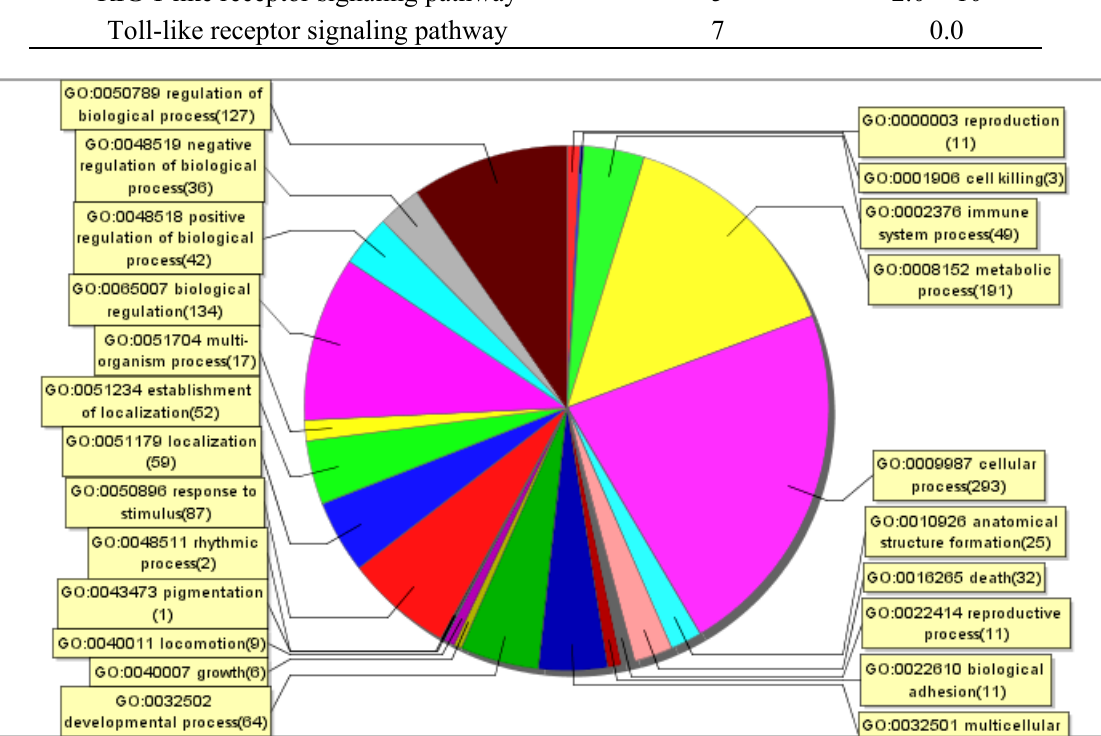
Figure 1. Enriched Gene Ontology terms in the biological process category among differentially expressed genes. After the mRNA microarray assay, significantly enriched Gene Ontology analysis in the biological process category among differentially expressed genes (fold change over non-infected ≥2) in Raw264.7 cells infected with SX09S-01 at 5 MOI for 2 h was performed by using SAS (ShanghaiBio Analysis System). Each color section represents a different biological process, and the gene number enriched in this section was shown following the biological process